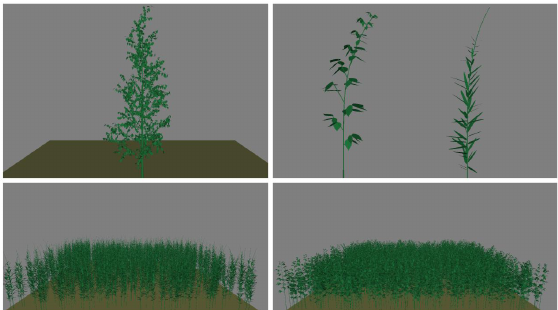
Figure 3. Geometric-optical vegetation models. A 3-m-high birch, individual raspberry and fireweed shoots, and a 6×6-m area of fireweed and raspberry canopies.